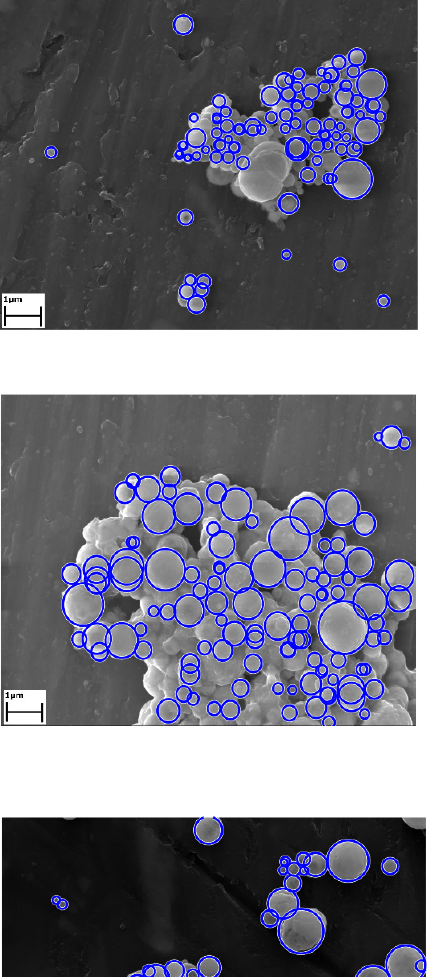
9 of 13 Figure 9. SEM analyses of mixed RE-Oxide powders synthesized with varying reaction temperatures ( a ) 700 °C; ( b ) 800 °C; ( c ) 900 °C; ( d ) 1000 °C. Applied image processing methods generate the black and white images from the original SEM images for determining the location and size of the RE-oxide nanoparticles. Since the particles are known to have spherical shapes [33], the Hough transform method was utilized for approximately defining the nanoparticles. The Hough transform draws